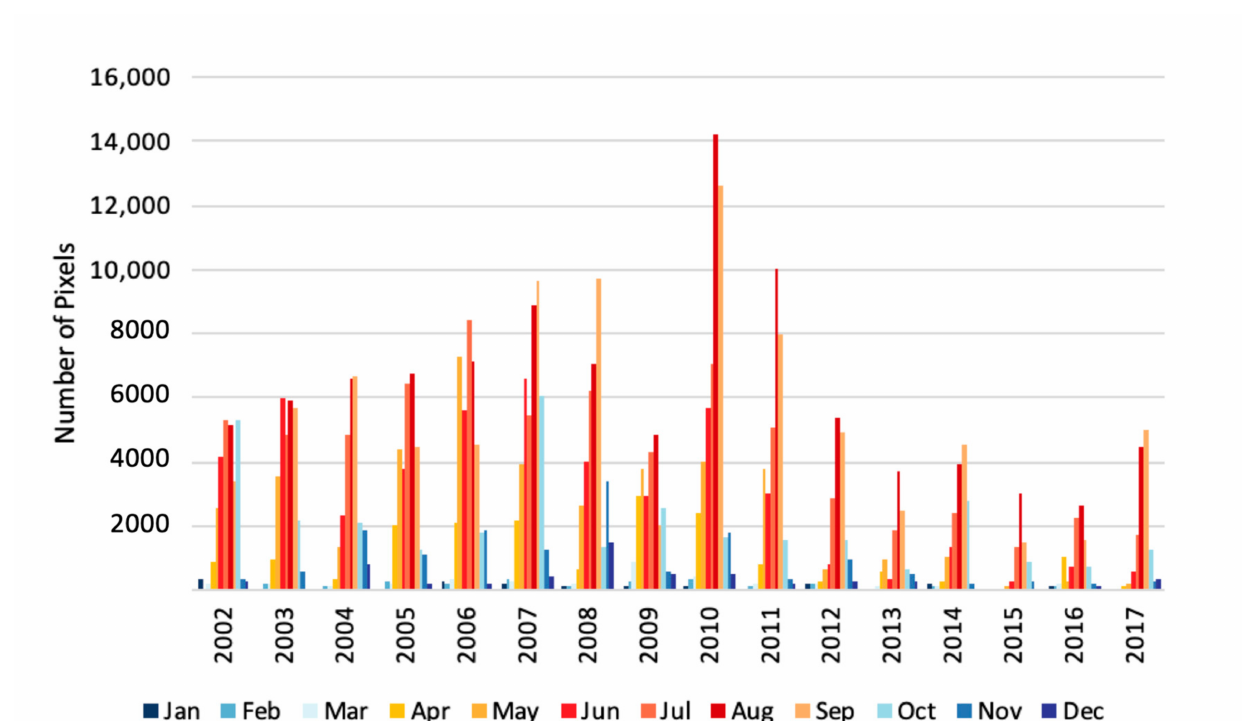
Figure 9. Bar chart representing annual fire regime for SP, based on frequency of monthly fire events. It also demonstrates general decline in fire events in